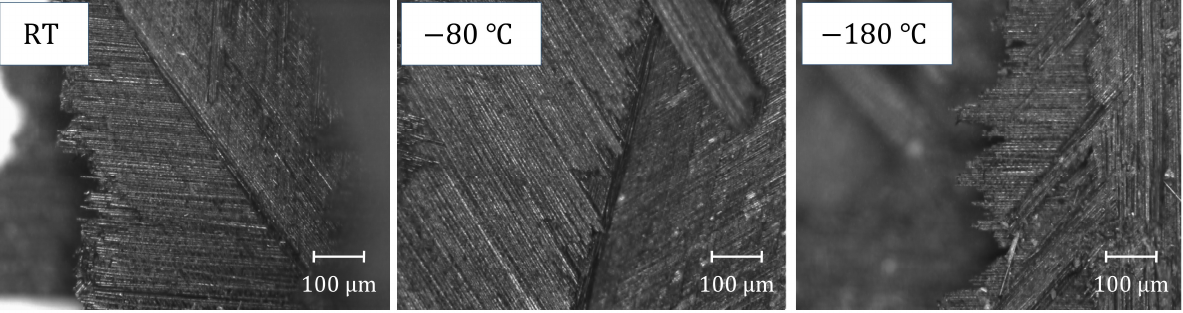
Figure 10. Optical microscope image of the fracture position after dynamic impact at different temperatures.